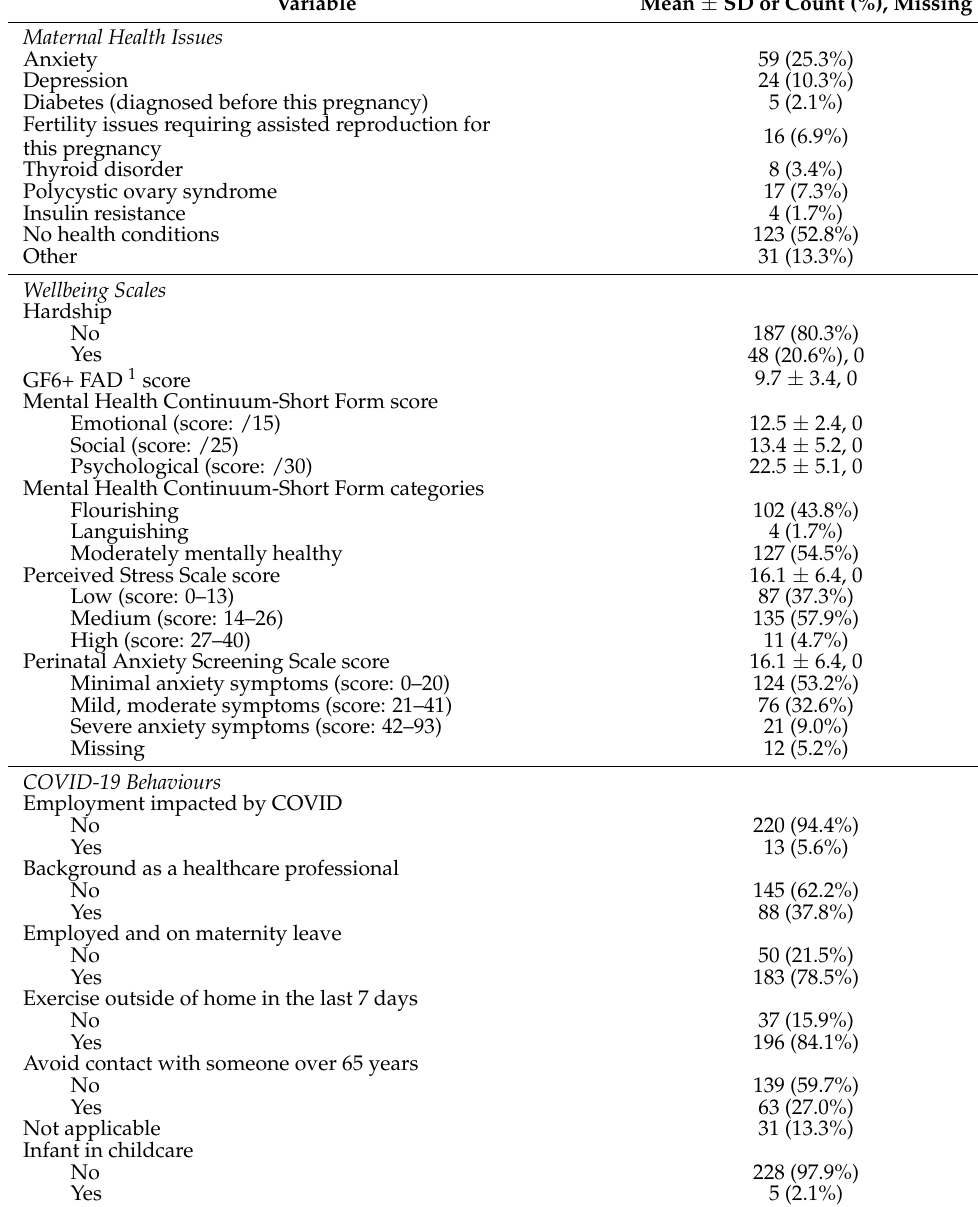
Table 3. Maternal health issues, wellbeing scales scores and categories, and COVID-19